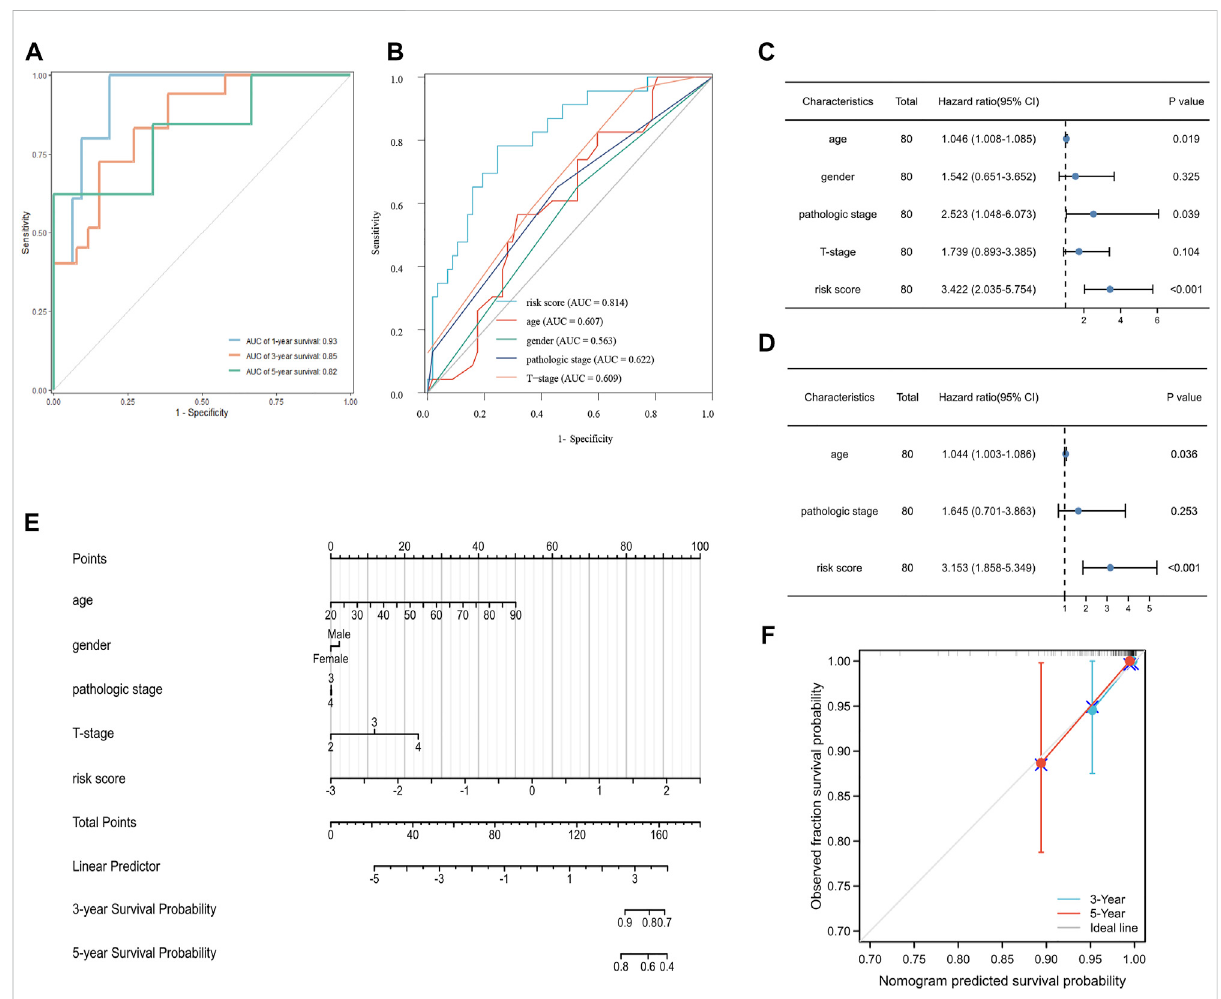
FIGURE 4 Validation of the prognostic signature in UVM. (A) The ROC curve and AUC of the signature at 1, 3, and 5 years. (B) The ROC curve and AUC for theriskscore,age,gender,pathologicstage,andTstage. (C) UnivariateCoxanalysisfortheriskscore,age,gender,pathologicstage,andTstage. (D) Multivariate Cox analysis for the risk score, age, and pathologic stage. (E) Nomogram to predict the 3-, and 5-year OS of patients with UVM. (F) Calibration plot of the nomogram at 3, and 5